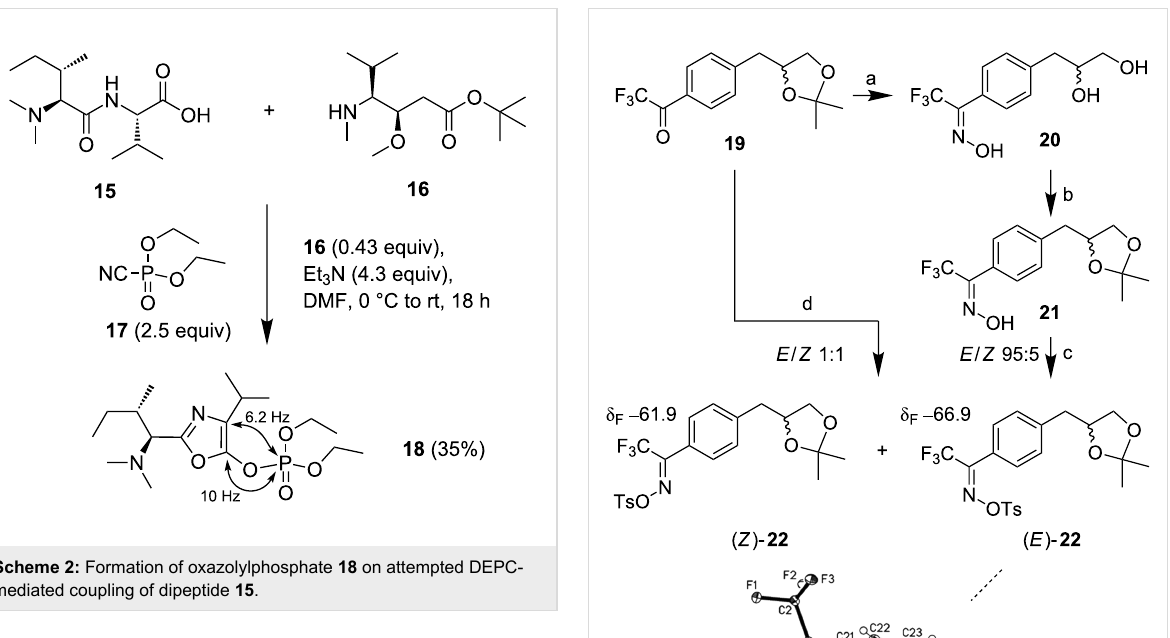
Racemic photo phenylpropanediol 25 was obtained